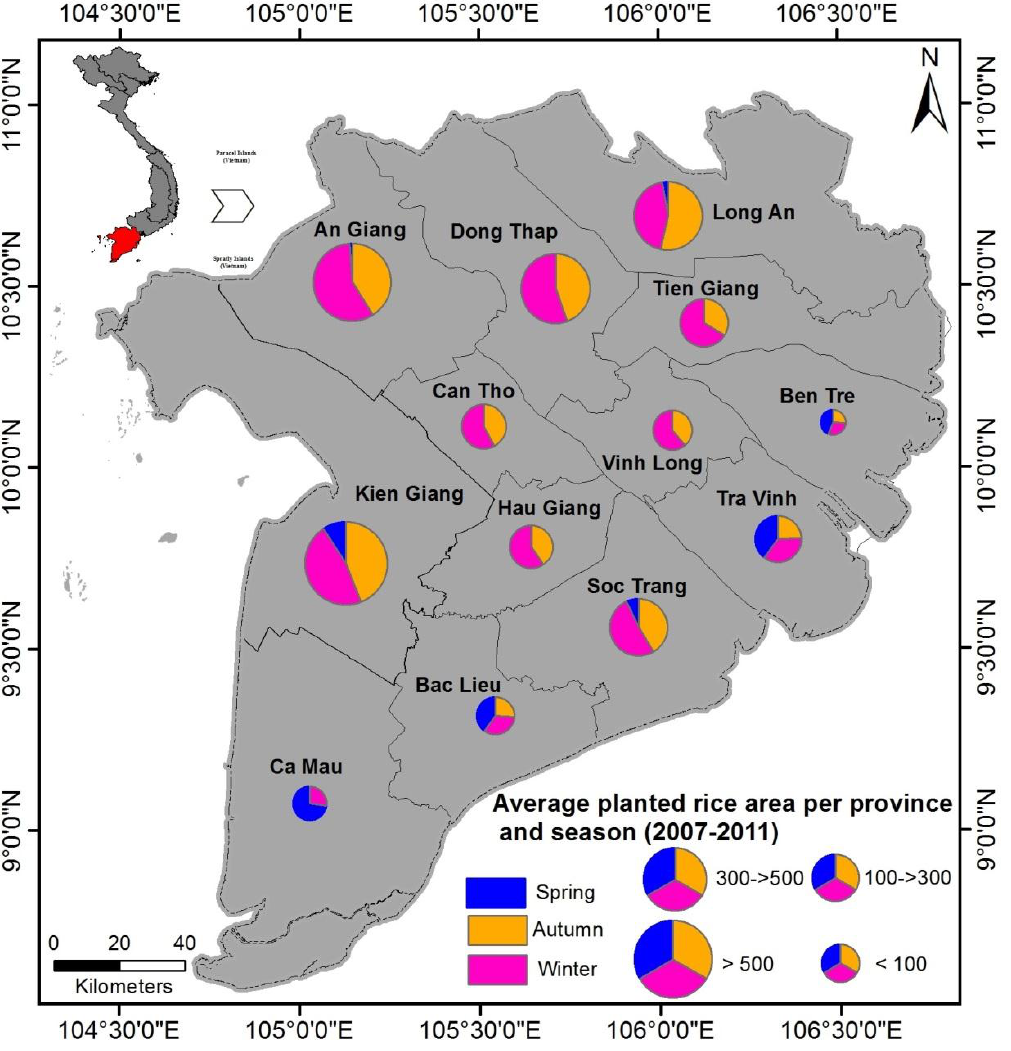
Figure 2. Planted rice area per province and season averaged for the period of 2007 to 2011 (Source: General statistics Office of Vietnam) (adapted from [18]).